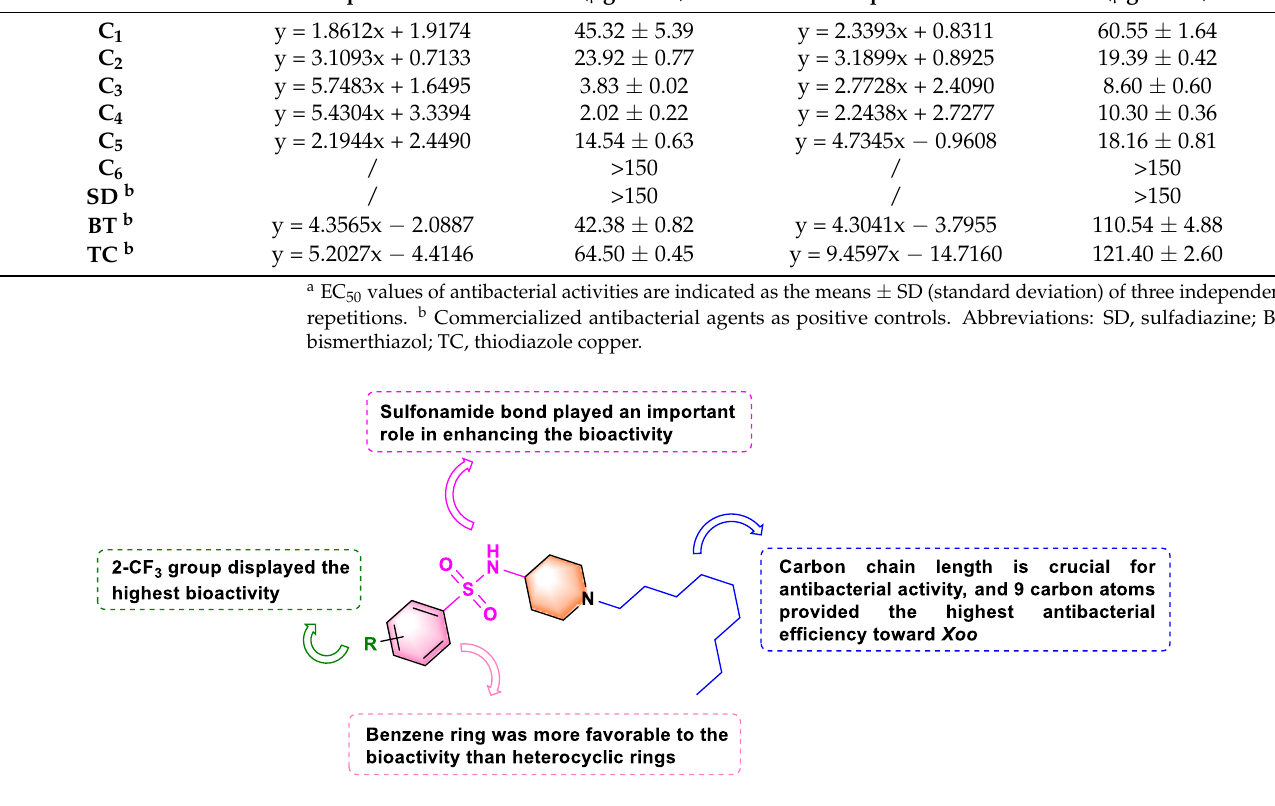
Figure 2. Diagram for structure−activity relationship (SAR)